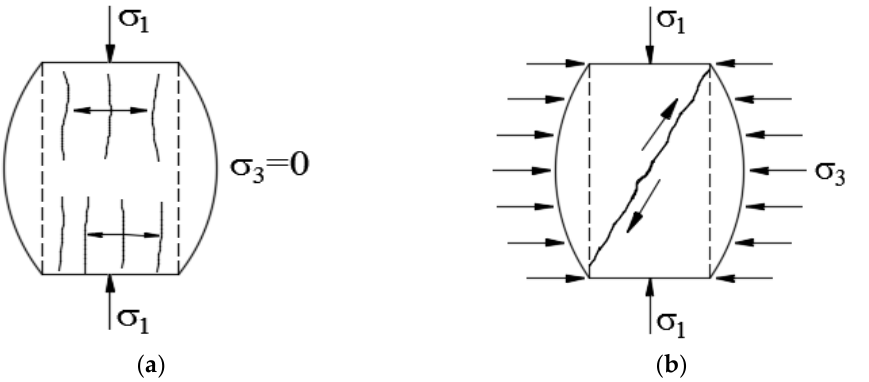
Figure 17. Model diagram of SFRC under different stress states. ( a ) Uniaxial compression state and ( b ) triaxial compression state.